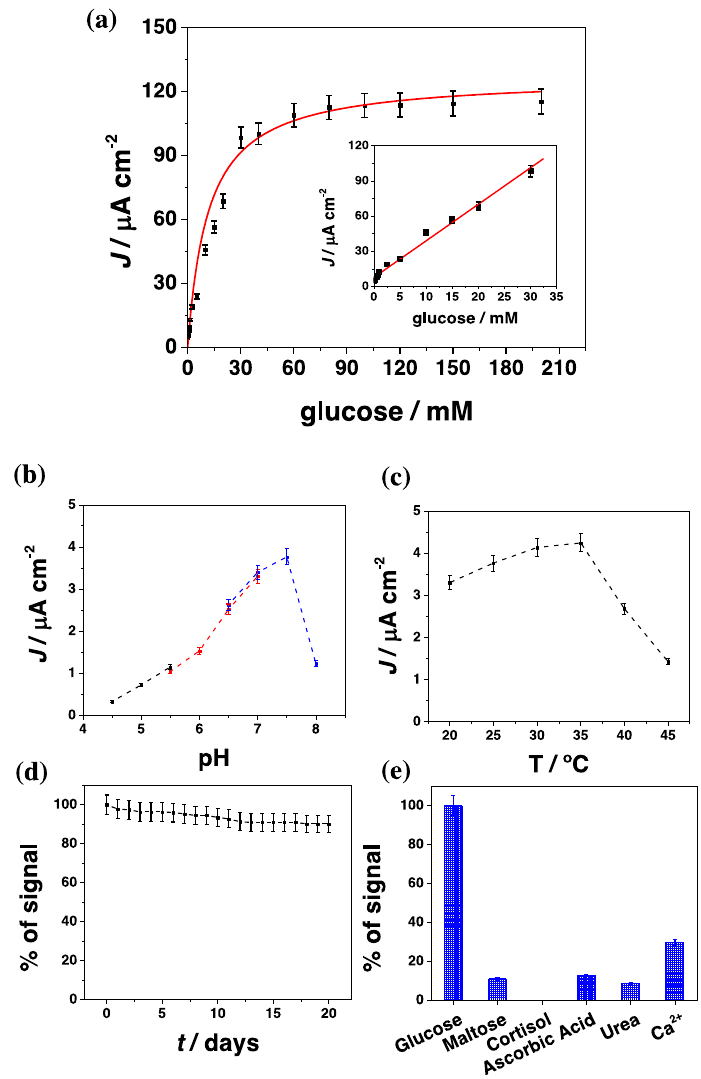
Figure 4. ( a ) Glucose biosensor calibration graph of Ct CDH C291Y/GA/4-APh,4-MBA/AuNPs/GC in 50 TRIS buffer pH 7.4 (0.1 M KCl); E app = 0.250 vs. Ag|AgCl sat ; flow rate 0.5 mL min − 1 ; inset: linear part of the calibration curve; ( b ) biosensor response over the pH range (4.5–8): 50 mM acetate buffer (black), 50 mM MOPS buffer (red) and in 50 mM TRIS buffer (blue), with E app = 0.250 vs. Ag|AgCl sat ; flow rate 0.5 mL min − 1 ; ( c ) biosensor response over the T range (20–45 °C) in TRIS buffer; ( d ) lifetime of Ct CDH C291Y/GA/4-APh,4-MBA/AuNPs/GC biosensor in presence of 750 μ M glucose solution; ( e ) influence of interfering compounds on glucose response in presence of 750 μ M glucose, maltose, cortisol, ascorbic acid, Ca 2+ . Experimental conditions ( c – e ): 50 TRIS buffer pH 7.4 (0.1 M KCl), E app = 0.250 vs. Ag|AgCl sat ; flow rate 0.5 mL min − 1 ; injection volume 50 μ L; T = 25 °C.